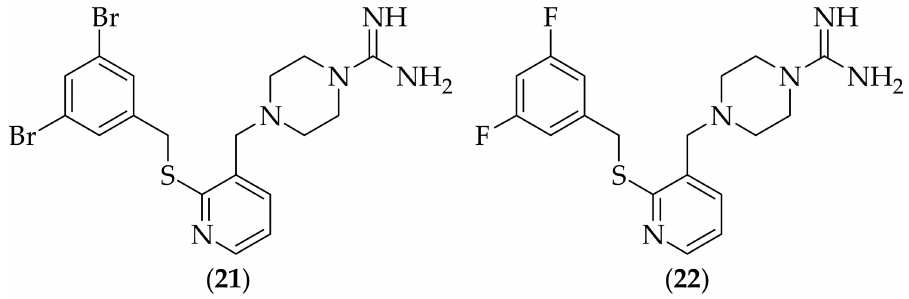
Figure 12. Fungistatic and fungicidal piperazine-1-carboxamidines ( 21 ) and ( 22 ).